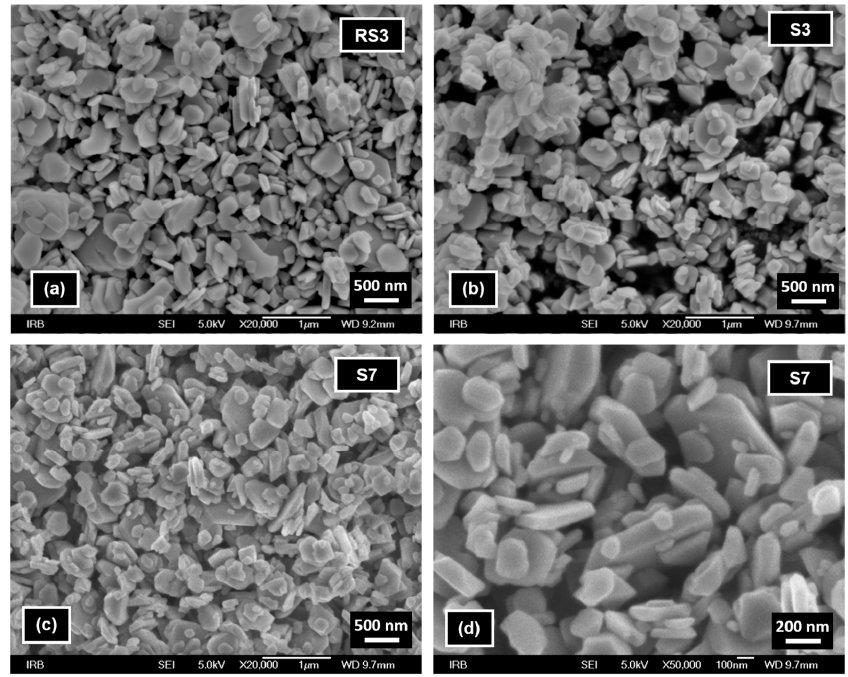
Figure 8. FE-SEM images of samples ( a ) RS3, ( b ) S3, and ( c ) S7 recorded at a magnification of 20,000×, and ( d ) sample S7 recorded at a magnification of 50,000×.